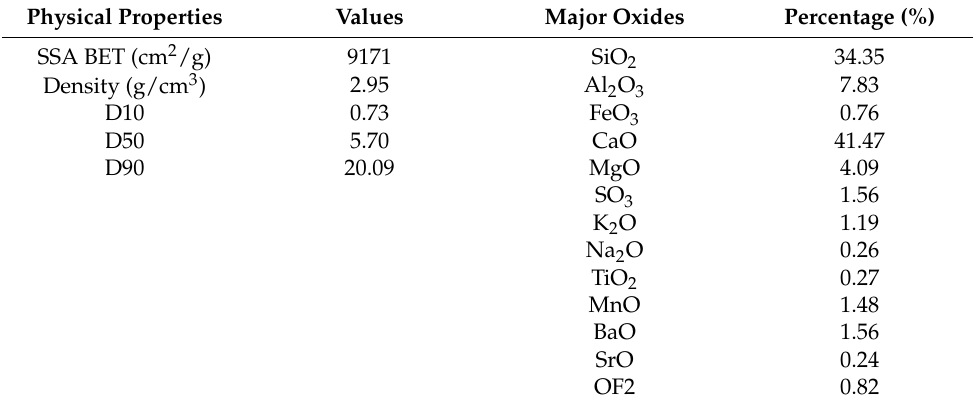
Table 2. GCBS physical properties and major oxide content.